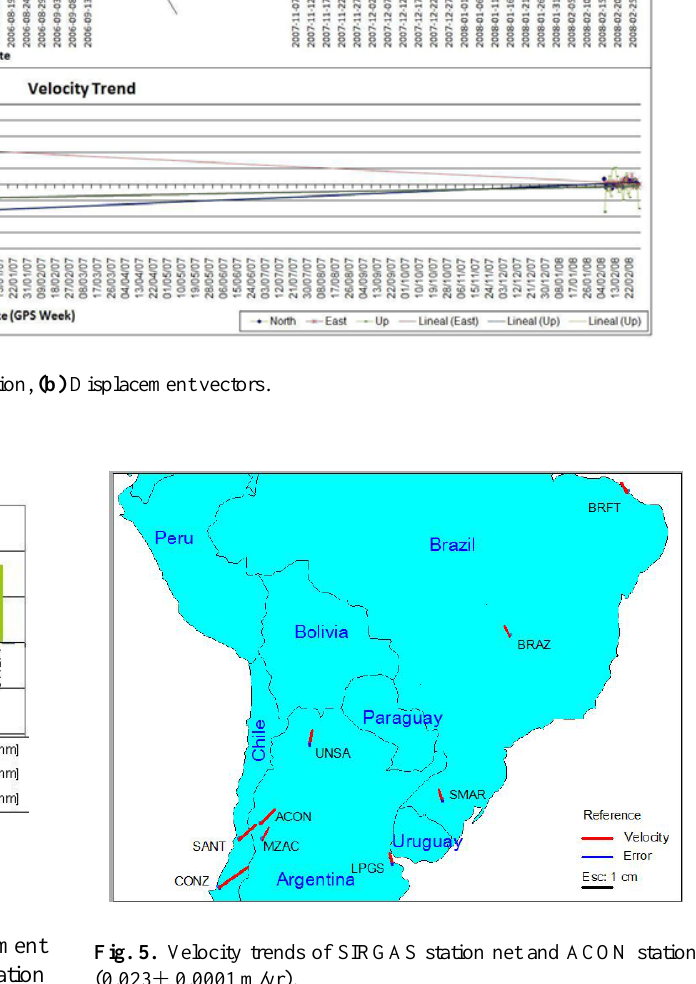
Figure 5. Velocity trends of SIRGAS station net and ACON station (0,023± 0.0001 m/yr) Fig. 5. Velocity trends of SIRGAS station net and ACON station (0.023 ±